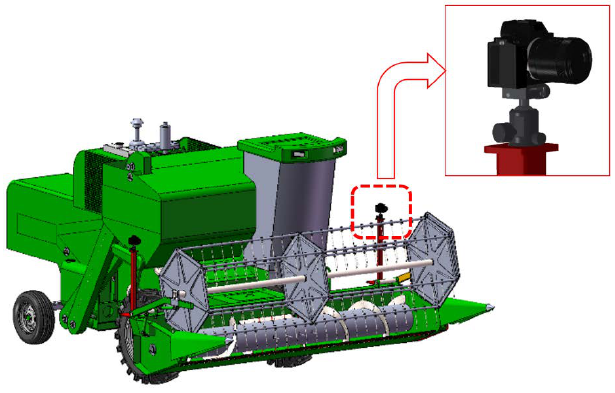
Figure 1. Camera mounting structure.